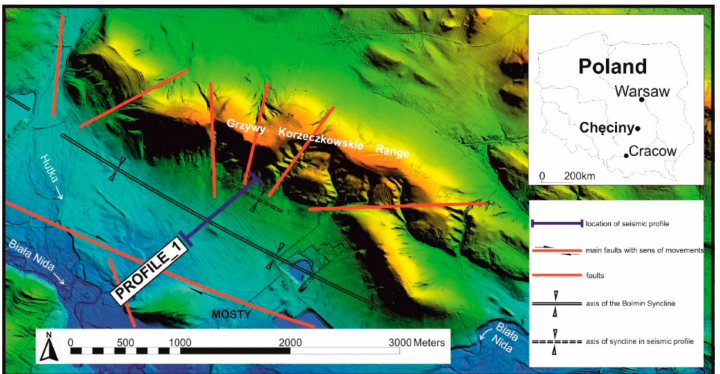
Figure 1. The studied area, Ch˛eciny in the Holy Cross Mountains. A fluvial area (with the sand mine) is located between culminations of Mesozoic rocks (Lindner et al., 2001; Cabalski et al.,